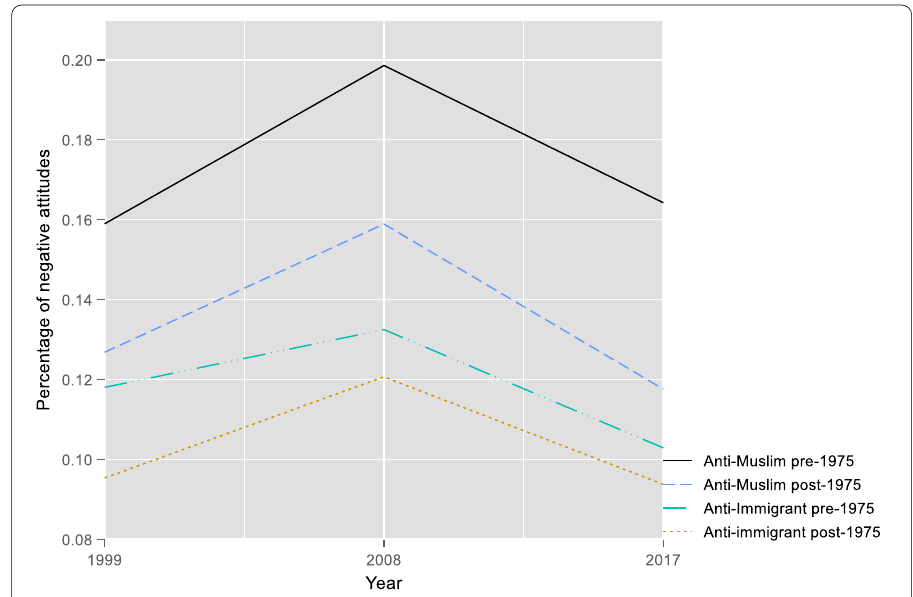
Fig. 6 Anti-Muslim and anti-immigrant attitudes by age group Western Europe